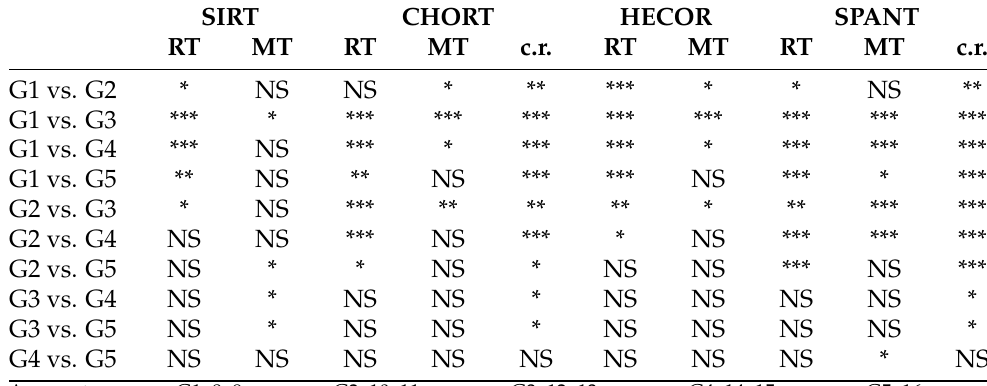
Table 3. Post-hoc